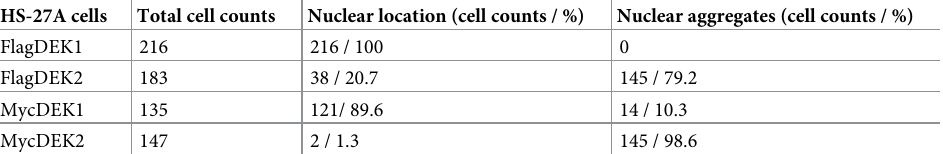
Table 2. Subcellular location of ectopic DEK